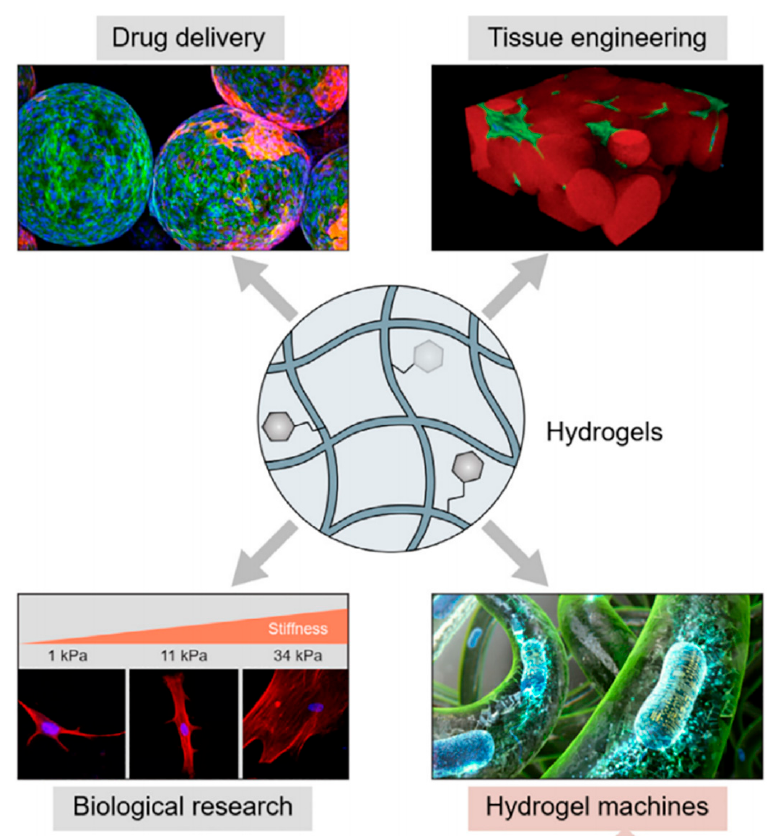
Figure 1. Schematic diagram of hydrogels in tissue engineering (Figure 1 is adapted from reference